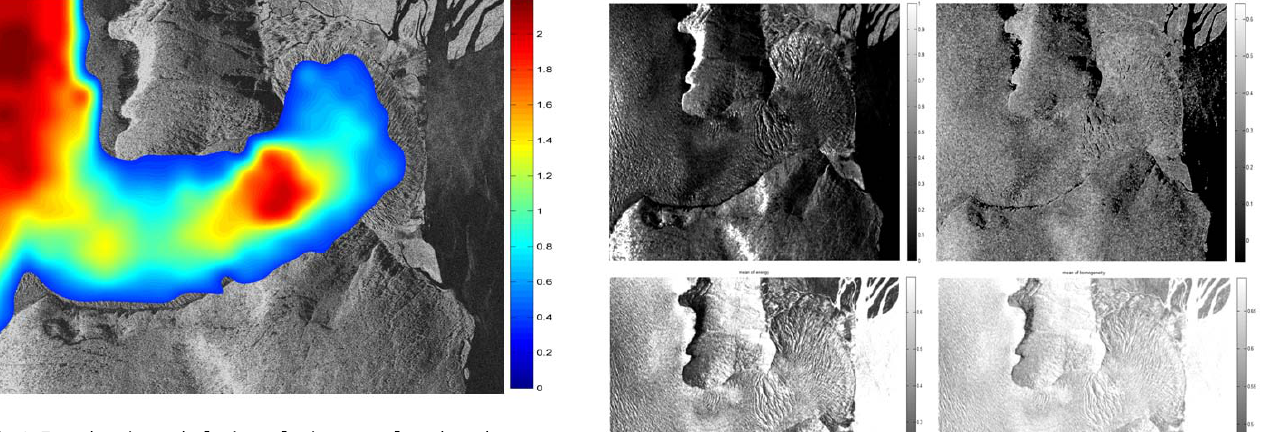
Based on the method described above, the original 14 features